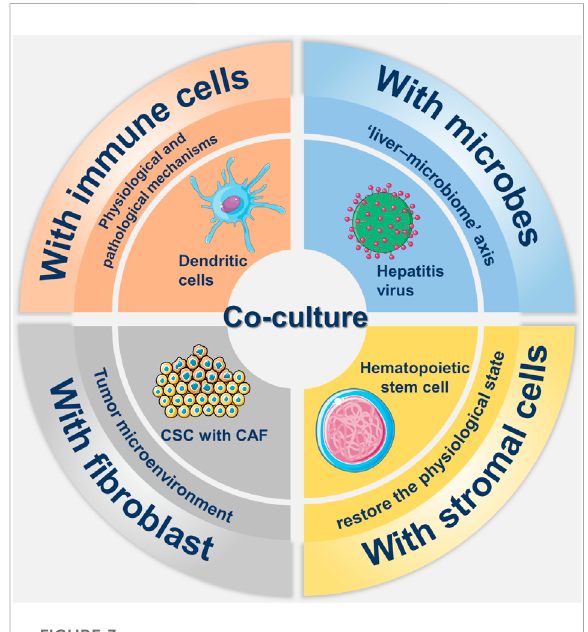
FIGURE 3 Overview about co-culture of liver organoids. There have been many researches in the fi eld in co-culture of liver organoid, whichmainlyincludesco-culturewithimmunecells,stromalcells, fi broblasts and microorganisms. The involvement of immune cells such as dendritic cells and stromal cells such as hematopoietic stem cells in co-culture helps to simulate the real environment in vivo . Co-culture with hepatitis virus not only re fl ects the role of the liver-microbe axis, but also allows for participation in disease modeling. Co-culture with cancer- associated fi broblast (CAF) in tumor modeling not only mimics the tumor microenvironment but also promotes the growth of cancer stem cells